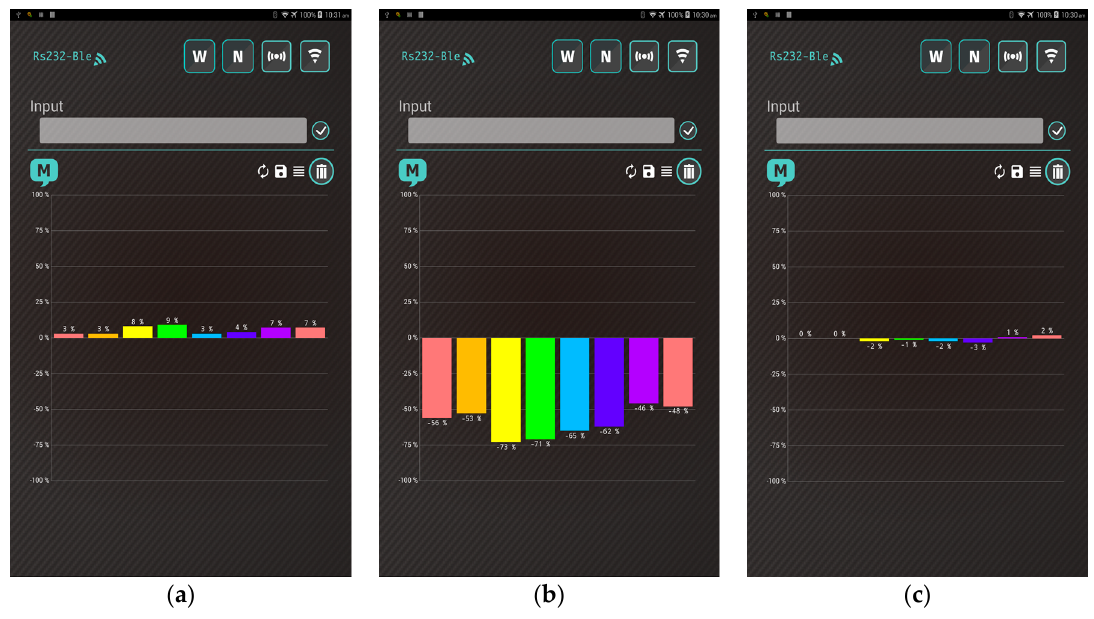
Figure 15. Screenshot of sensor response pattern to different operating conditions: ( a ) exposure to 1000 ppm ammonia; ( b ) exposure to 1000 ppm nitrogen dioxide; ( c ) exposure to 10 ppm toluene.